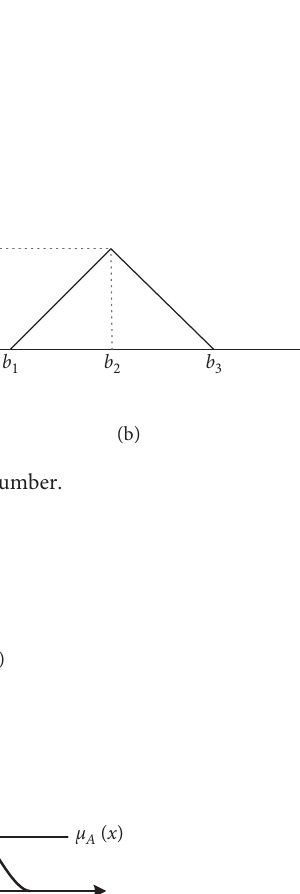
Figure 3: Distribution of X probability and triangular membership function of event A .